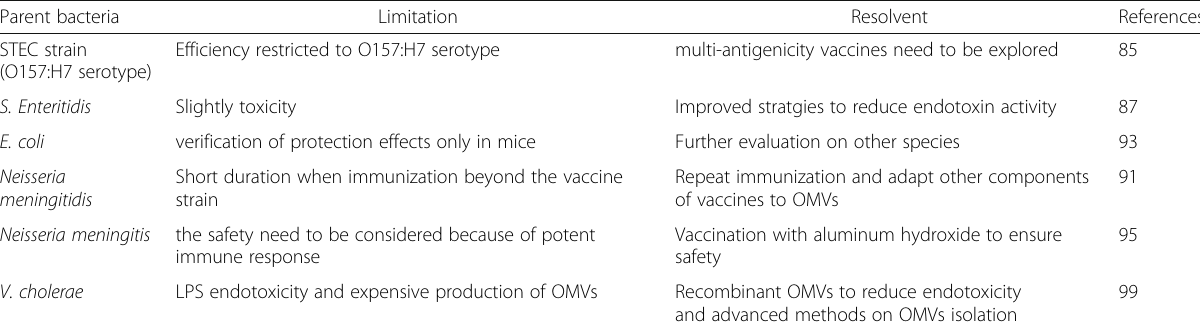
Table 2 Limitation of vaccines based on bacterial OMVs Parent